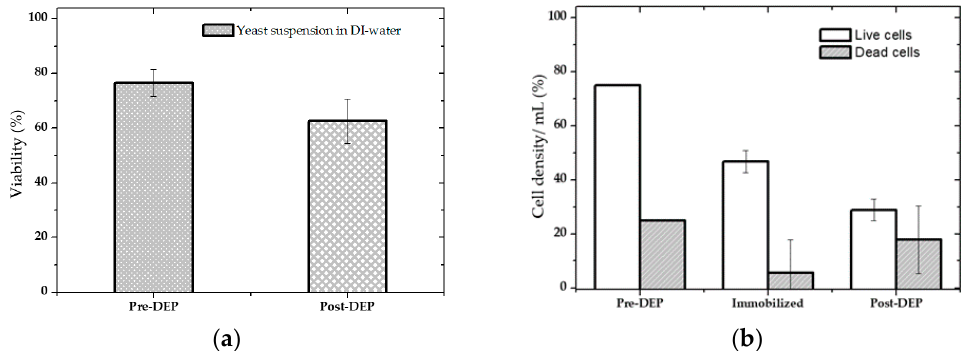
Figure 12. Separation estimation of live/dead yeasts in a mixture. The live and dead cells mixture was 3:4 in the suspension before separation: ( a ) Viability estimation before (Pre-DEP) and after measurement (Post-DEP); ( b ) Percentage of trapped and released live and dead cell densities after DEP. The separation condition was: 20 Vpp, 1MHz, and 1 µm·s − 1 flow rate.